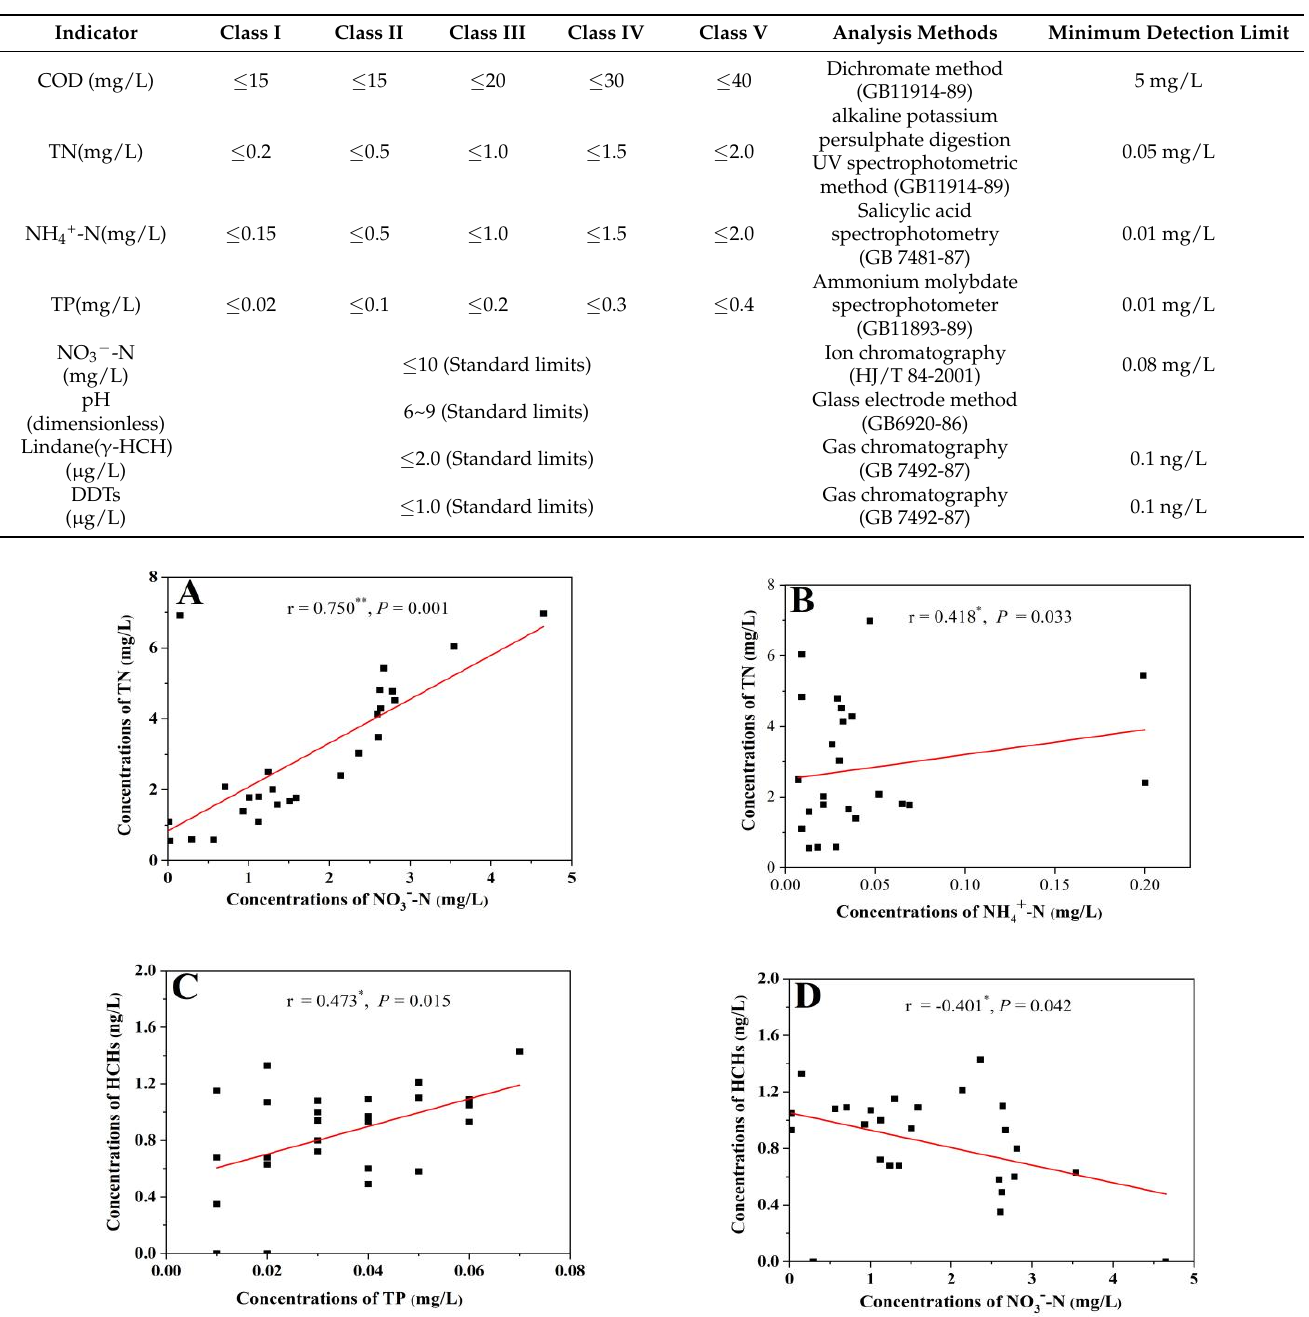
Table 2. Surface water quality monitoring standards (GB3838-2002).